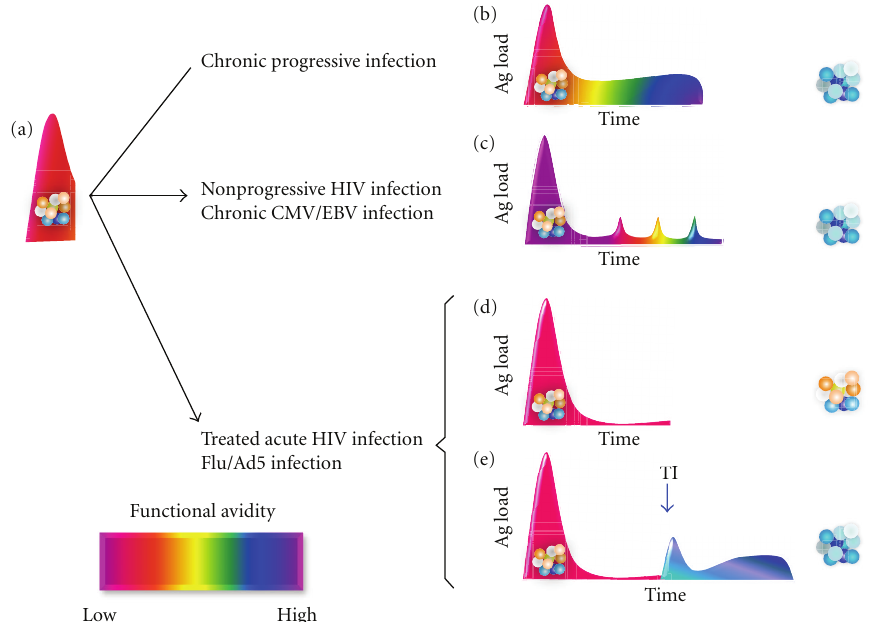
Figure 2: Proposed Model of the relationships between antigen exposure and functional avidity of T cells. Functional avidity of virus-specific CD8 T cells during (a) acute infection and then translation after transition to the chronic phase for (b) uncontrolled virus infection (such as progressive HIV infection) or (c) controlled but persistent virus infection (such as nonprogressive HIV, cytomegalovirus [CMV], or Epstein- Barr virus [EBV], or (d) after virus clearance (such as influenza [Flu] or adenovirus [Ad5], or early treatment of acute HIV infection). (e) Increase in the functional avidity of HIV-specific CD8 T cells of patients treated during acute infection who interrupted the antiretroviral therapy [TI] and experienced a virus